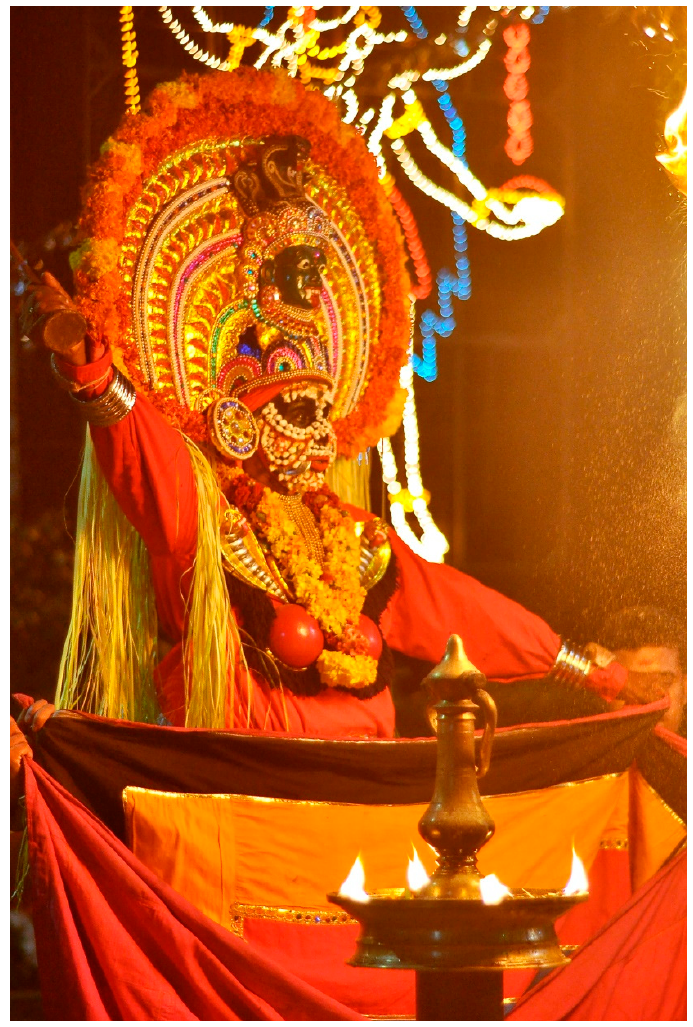
Figure 1. Bhadrak ā ḷ i in mu ṭ iy ē ṯṯ u' (Photo by Punnackal Girijan Narayanan Marar). Figure 1. Bhadrak¯al